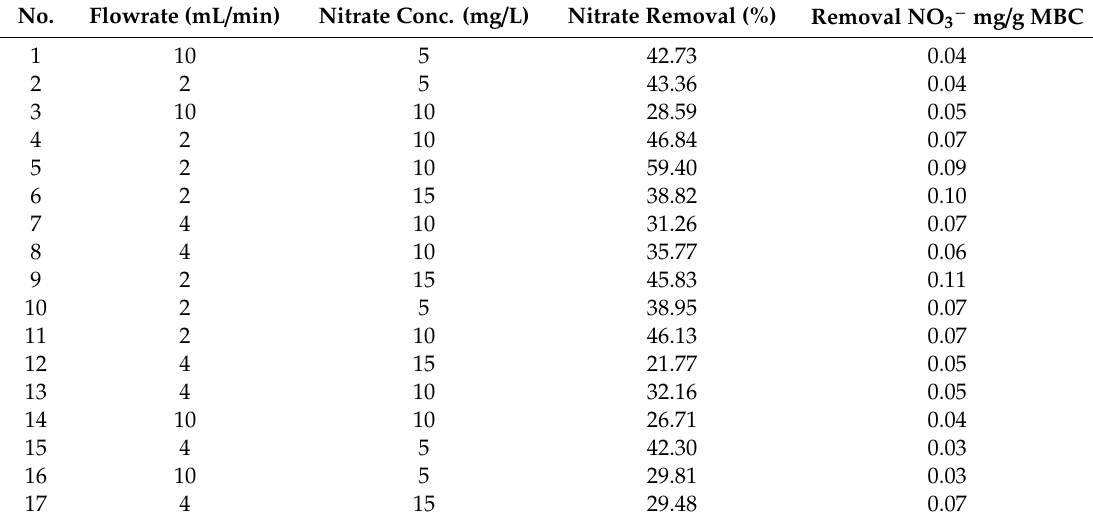
Table 3. Nitrate removal with different treatment scenarios.